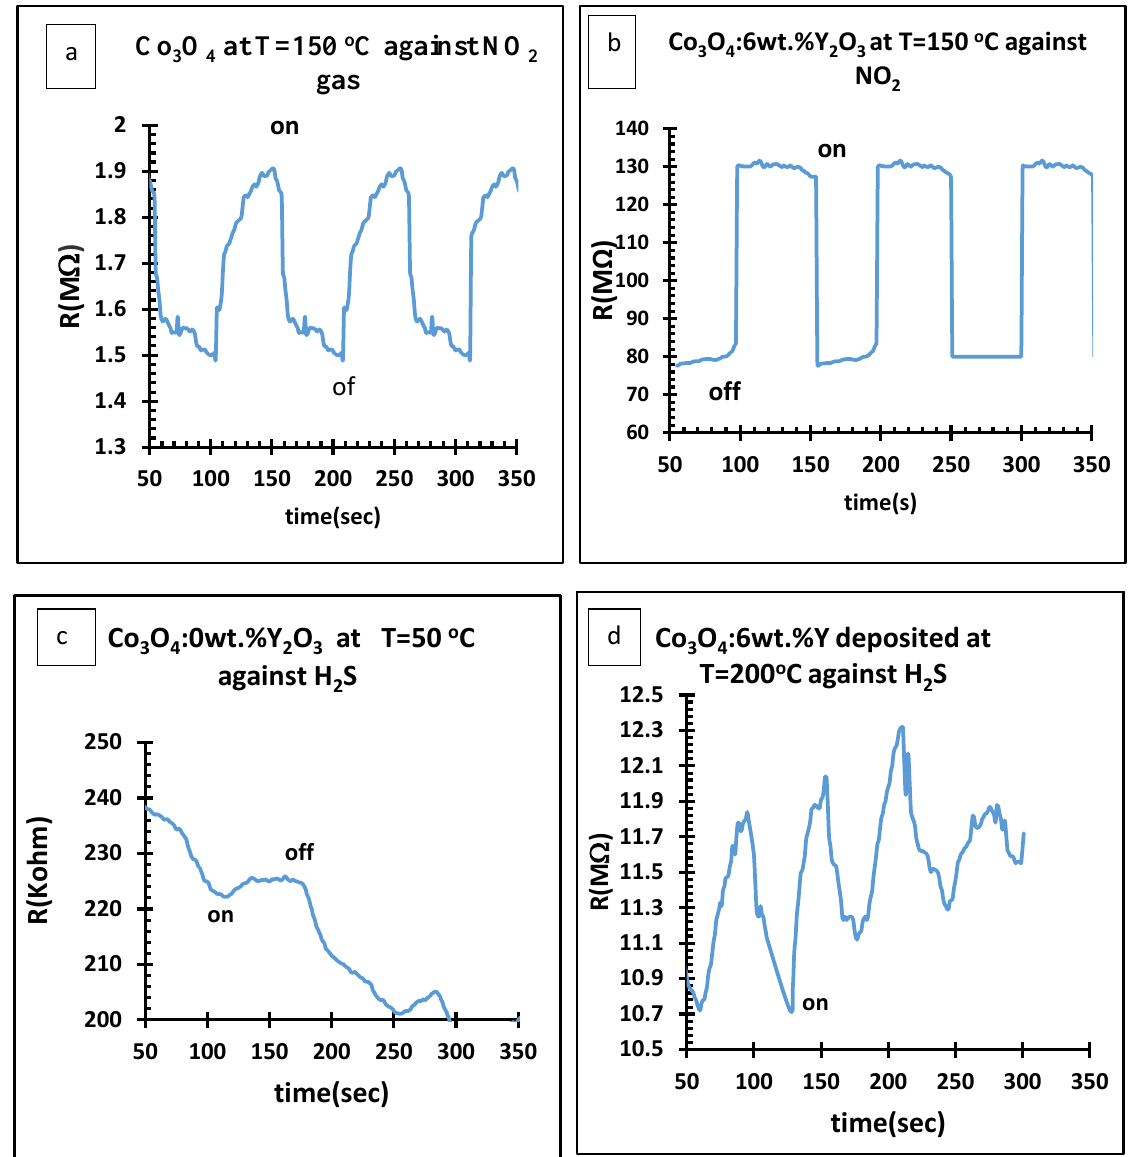
Figure 6: Variation of resistance with time for Co